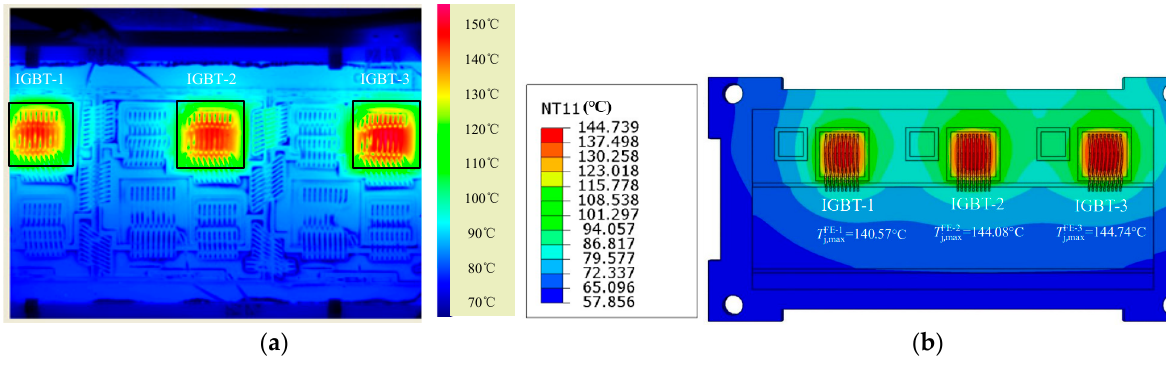
Figure 13. Comparison of the temperature fields of the IGBT module under the DC-2 experimental conditions: ( a ) Infrared image taken by the IR camera of the IGBT module at the moment of power-off; ( b ) The temperature field when the IGBT module reaches the maximum temperature obtained from the electrical–thermal FE analysis.